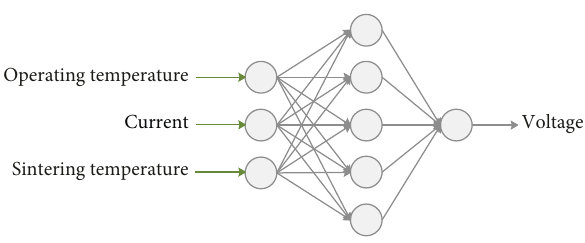
Figure 2: Artificial neural network (3-5-1) structure.